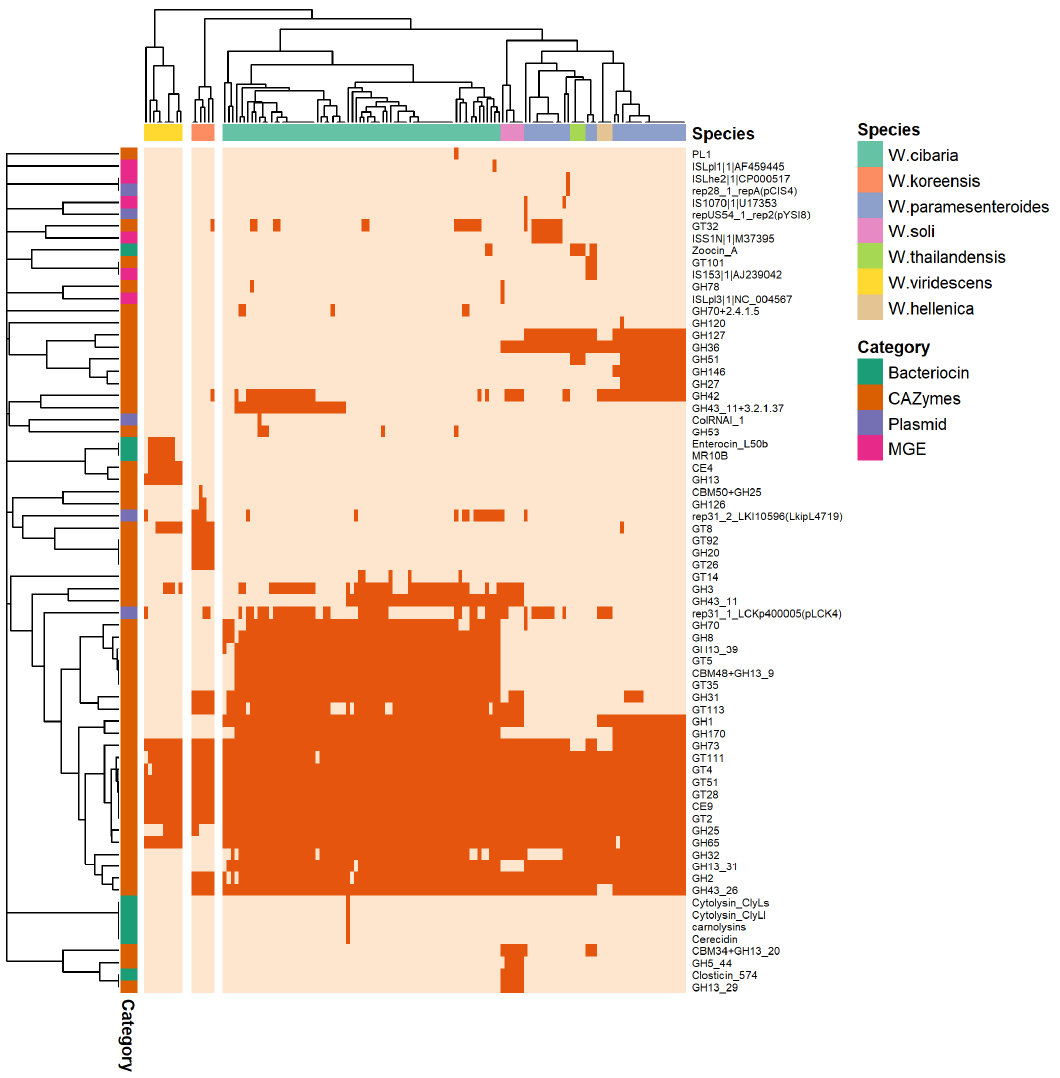
Figure 3. Cluster heatmap generated using an MGE (plasmids and insertion sequences), CAZyme, and bacteriocin gene presence-absence data matrix of all Weissella spp. isolates ( n = 136).